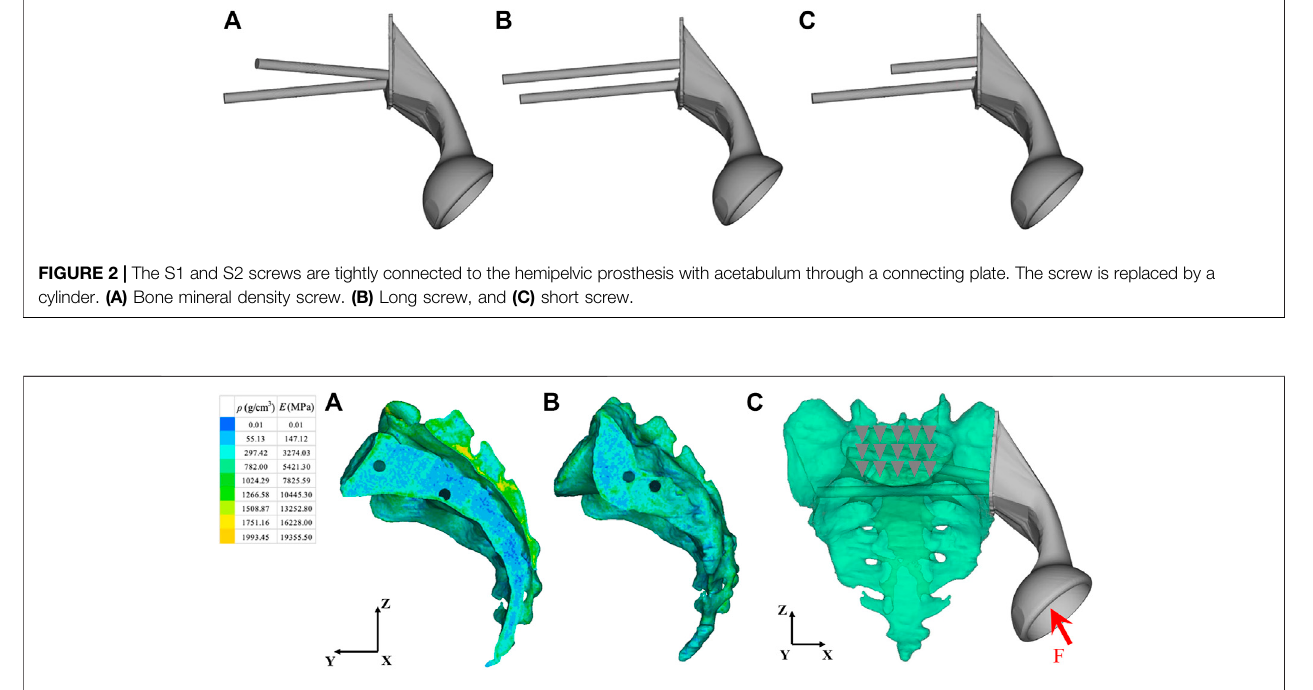
FIGURE 3 | Material properties of inhomogeneous sacrum and model load and constraint. (A) Internal material properties of the sacrum. (B) External material properties of the sacrum. (C) A load was applied to the center of the acetabulum. The constraint was set on the upper surface of S1 vertebral body. ρ : Bone mineral density; E: Elastic modulus. The arrow and triangles represent the load and constraint of the FEA